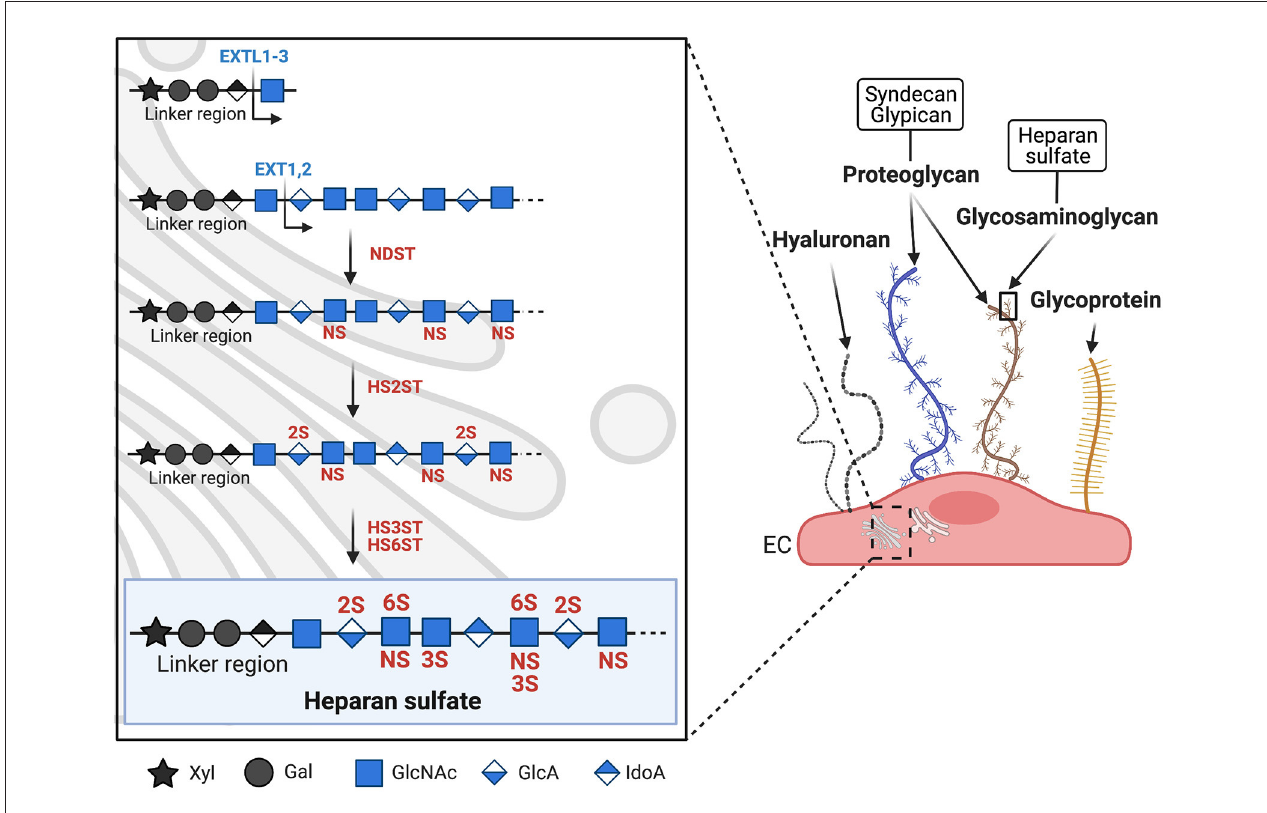
FIGURE 1 | Biosynthesis and structure of the endothelial glycocalyx. Schematic representation of the major glycocalyx components covering the luminal surface of microvascular endothelial cells (EC). On the right panel, syndecan (blue) and glypican (brown) are shown as two examples of proteoglycans (PGs, see text chapter ’Biosynthesis and composition of the endothelial glycocalyx’). PGs carry long glycosaminoglycan (GAGs) side chains, while other glycoproteins (shown in yellow) carry shorter, unbranched carbohydrate side chains. The left panel shows the biosynthesis of heparan sulfate (HS), the major GAG expressed on EC. HS biosynthesis takes place in the Golgi apparatus and is mediated by different enzymes. Synthesis is initiated by the enzyme EXTL1-3 which adds the first sugar to the linker region. Chain elongation is performed by EXT1-2 which add GlcNAc and GlcA. Sulfotransferases then initiate HS sulfation, starting with NDST which sulfates GlcNAc at the N-acetyl position. HS2ST sulfates uronic acid, HS3ST and HS6ST finish sulfation by adding sulfate respectively to the 3-O and 6-O position of GlcNAc. Xyl, xylose; Gal, galactose; GlcNAc, N-acetylglucosamine; GlcA, glucuronic acid; IdoA, iduronic acid; NS, N-sulfation; 2S, 2-O sulfation; 3S, 3-O sulfation; 6S, 6-O sulfation; EXTL, exostosin-like glycosyltransferase; NDST, N-deacetylase/N-sulfotransferase; HS2ST, HS 2O-sulfotransferase; HS3ST, HS 3O-sulfotransferase; HS6ST, HS